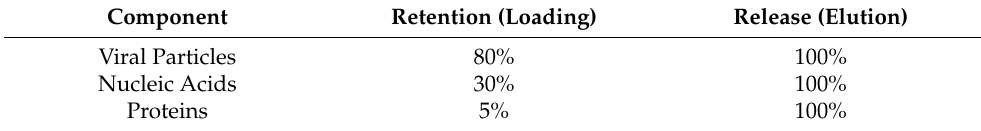
Table 7. Retention and release parameters for anion exchange